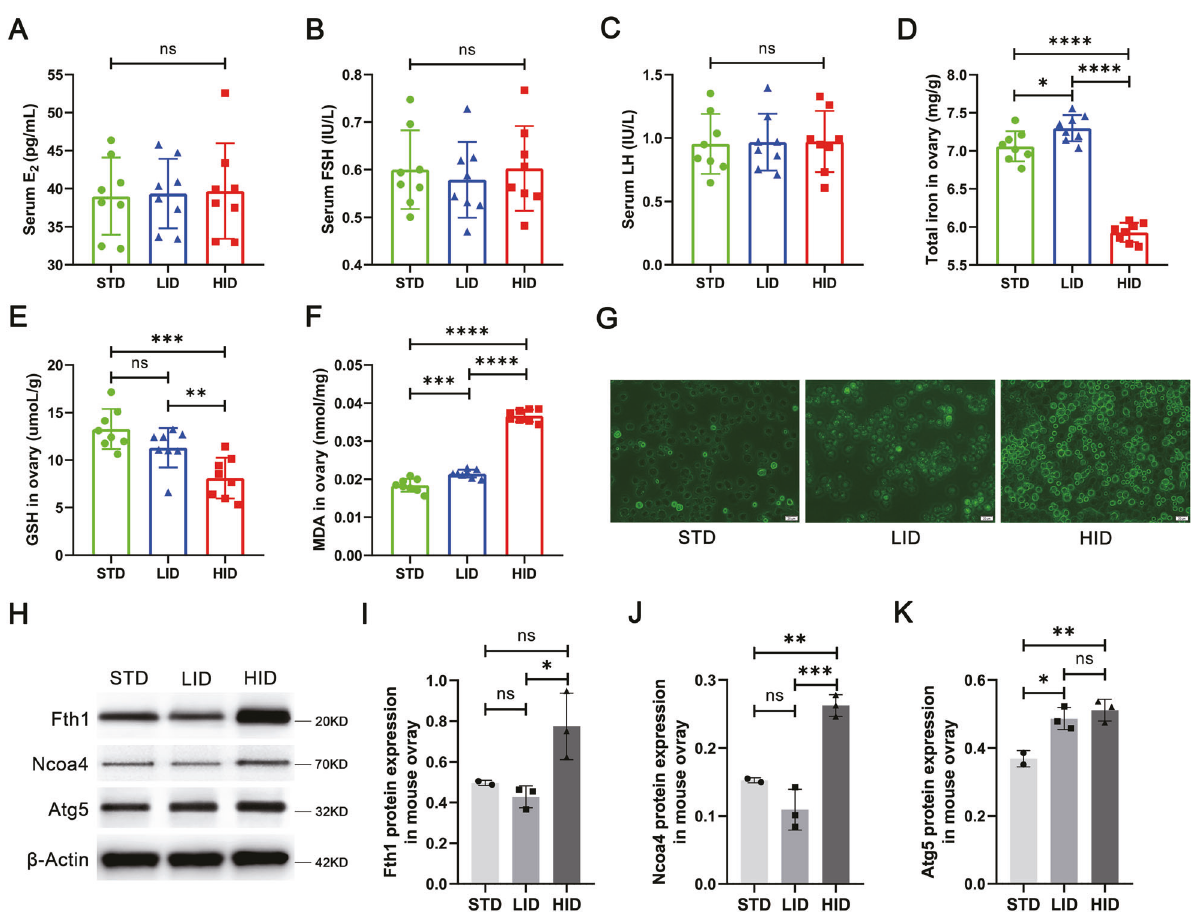
Fig. 5 Construction of an iron overload mouse model. A – C Serum levels of E 2 , FSH, and LH in standard iron (STD), low iron (LID), and high iron (HID) diet feeding groups ( n = 8). D – F Total iron, GSH, and MDA levels in the ovary tissues of mice in each group ( n = 8). G Representative images of ROS fl uorescence staining of ovarian mouse granulosa cells in three groups of mice. Scale bar = 20 µm. H – K Western blot analysis of ferritinophagy-related proteins, FTH1, NCOA4, and ATG5 in mouse ovary tissues in the STD, LID, and HID group. The expression of β -actin was used as an internal control. All data are expressed as means ± SD and analyzed by one-way ANOVA. * P < 0.05, ** P < 0.01, *** P < 0.001, **** P < 0.0001, and ns, no signi fi